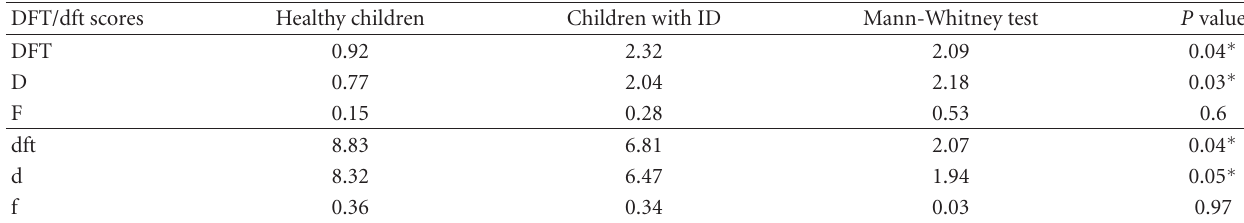
Table 1: DFT and dft scores in healthy children and children with ID.